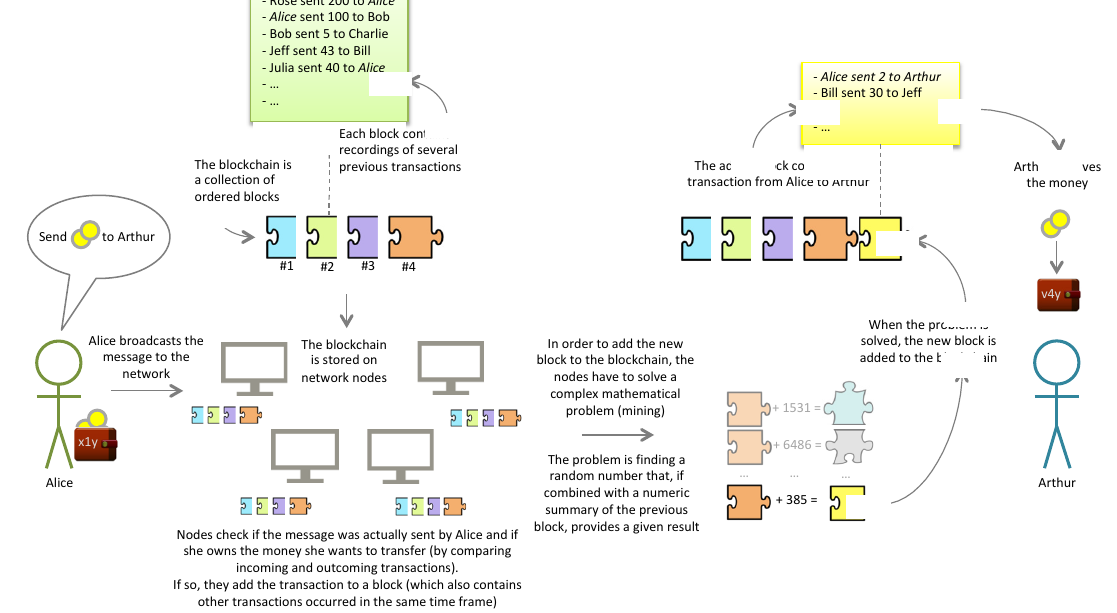
Figure 1. Performing transactions on the blockchain.